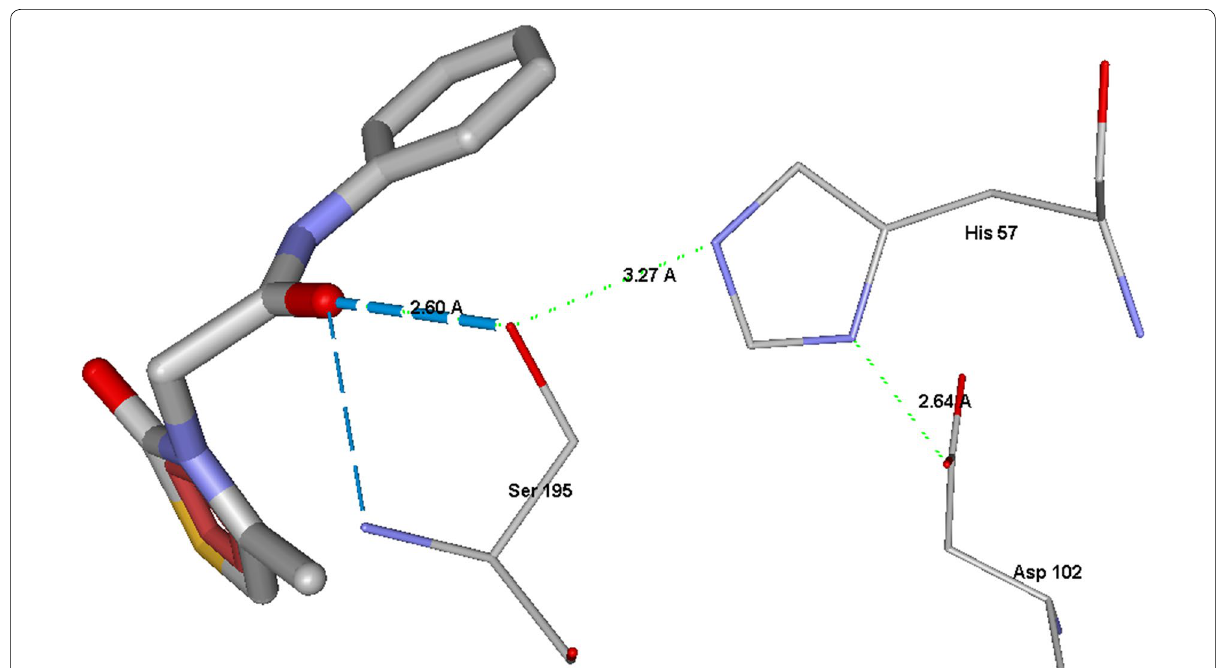
Fig. 10 Orientation compound 2e docking pose (thick cylinders) with respect to residues of the catalytic triad (thin cylinders). Hydrogen atoms are hidden for clarity. Hydrogen bonds are shown by blue dashed lines. Segments of the proton transfer channel are indicated as light-green dashed